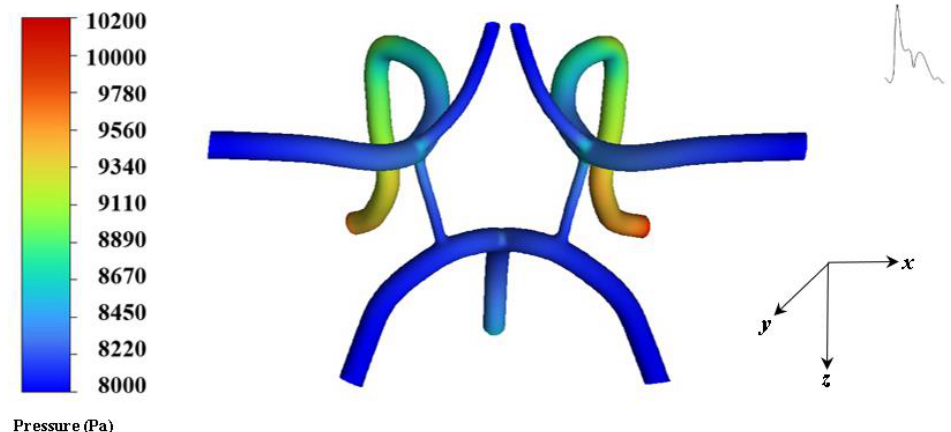
Figure 6. Contour of pressure at systole.